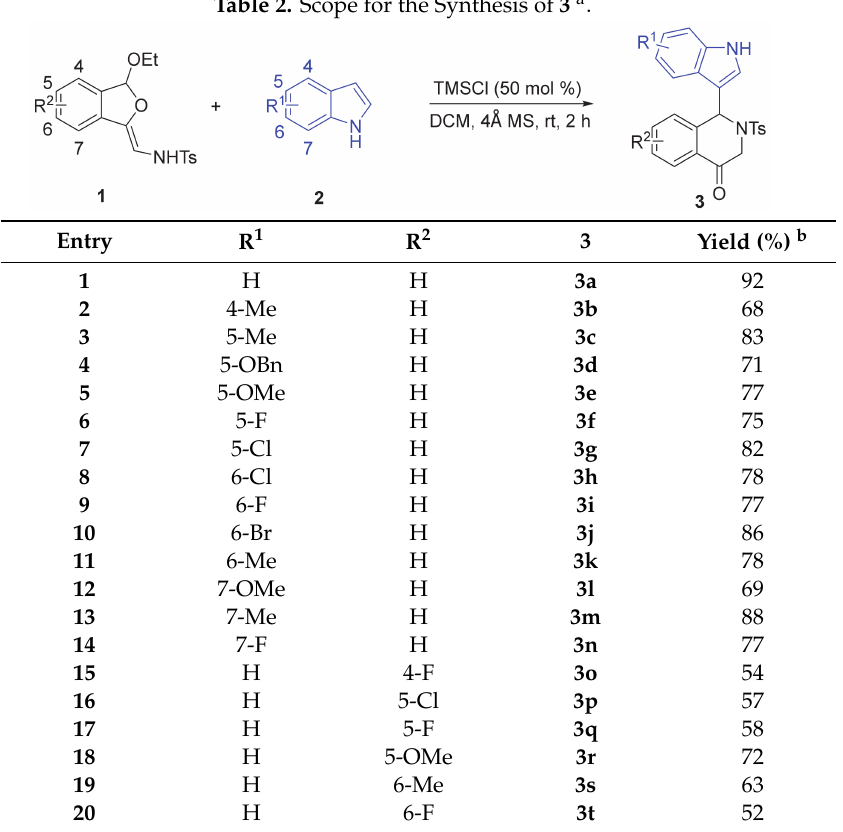
Table 2. Scope for the Synthesis of 3 a .